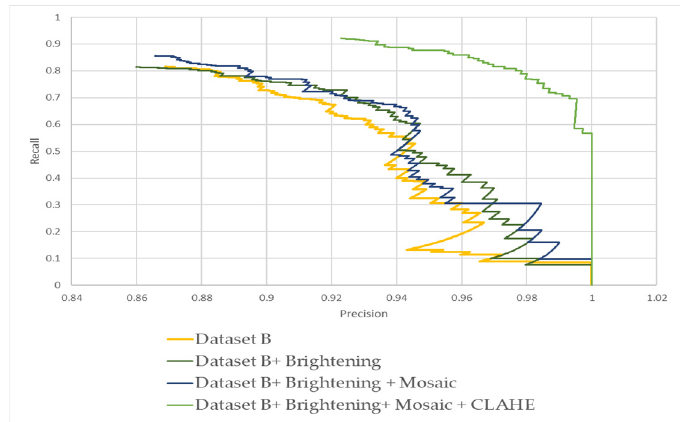
Figure 12. Detection results with different augmentation results. ( a ) Result After Training with Dataset B; ( b ) Result After Training with Dataset C; ( c ) Result After Training with Dataset D; ( d ) Result After Training with Dataset E.